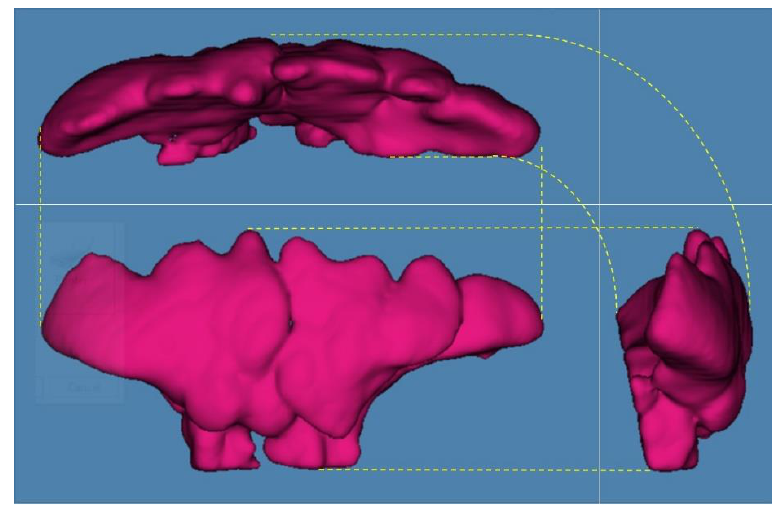
Figure 2. Representative three-dimensional image of the frontal sinus.